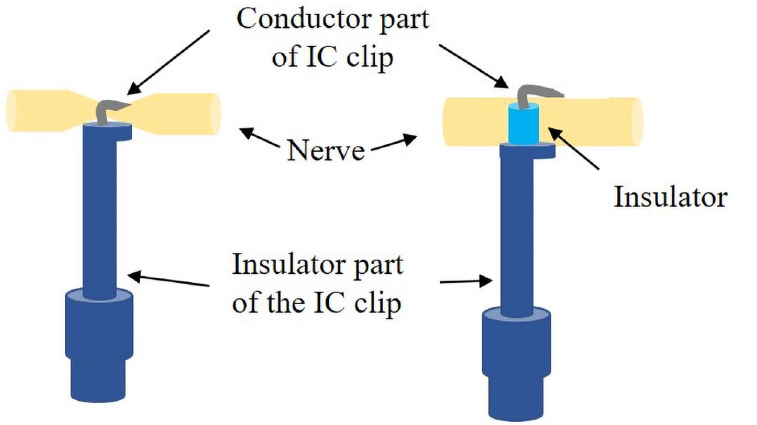
Fig 1. Schematic illustration of nerves pinched by integrated circuit (IC) clips, with and without spacers. The left illustration shows the IC clips without spacers, whereas the right illustration shows them with spacers. All impedance measurements were performed with